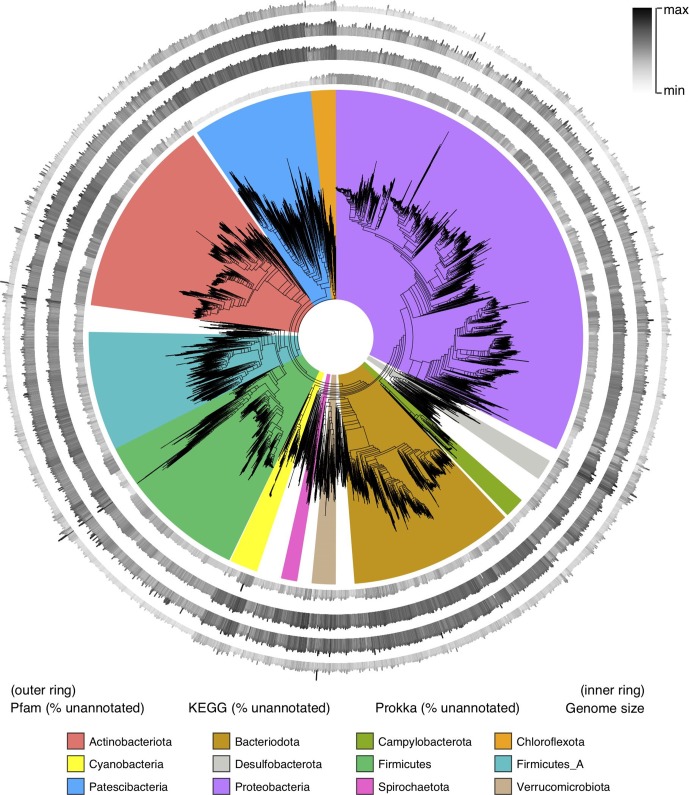
Genome annotation incompleteness across the bacterial tree of life. Annotation incompleteness has been mapped to the outer edges of the tree of life obtained from AnnoTree [1], which was originally derived from the GTDB [2]. The height of each bar (and colour) depicts traits (annotation incompleteness and genome size), which have been normalized separately for each metric. For annotation incompleteness, the gradient goes from 0 % (minimum) to 100 % (maximum). Four metrics are shown, including annotation incompleteness as determined using Prokka (outer ring), followed by that determined using Pfam, that determined using KEGG and genome size (inner ring).